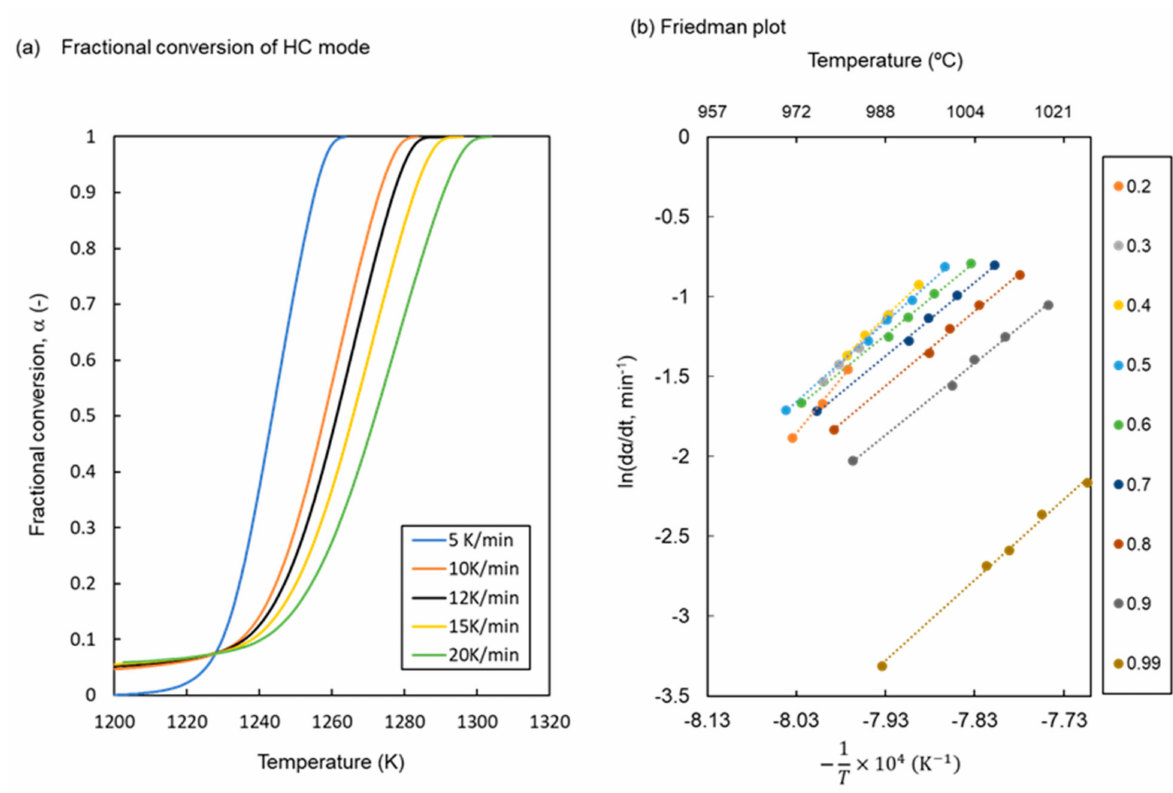
Figure 3. ( a ) Temperature variations in the fractional conversion of the long-term cycled sample during the HC mode. ( b ) Friedman plot of the long-term cycled sample to calculate the apparent activation energy against each value of the fractional